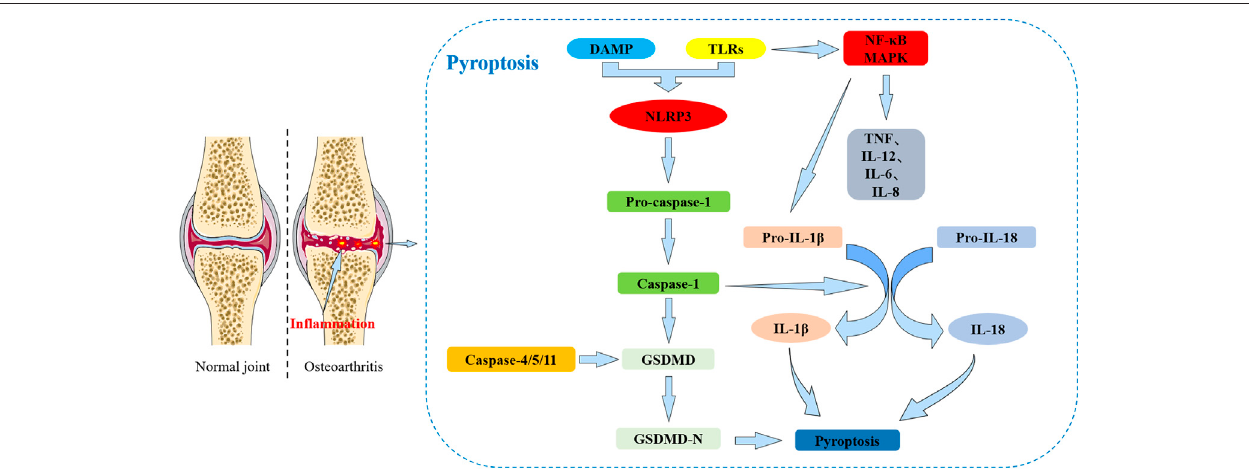
FIGURE1| Therelationshipbetweenpyroptosisandosteoarthritis(OA).Pyroptosis:DAMPsandTLRscaninteracttoexacerbatethein fl ammatoryresponse.TLRs initiateasignalingcascadeleadingtocellactivation,increasedreleaseoftheNLRP3in fl ammasome,activationofNF- κ BandMAPKsignalingpathway,andproductionof associated in fl ammatory factors (including TNF, IL-12, IL-6, IL-8 and pro-IL-1 β ) that in turn activate a strong in fl ammatory response. The in fl ammatory response promotes the increased release of IL-1 β and IL-18 on the cartilage surface exacerbating cartilage damage and also enhancing pyroptosis signaling. The